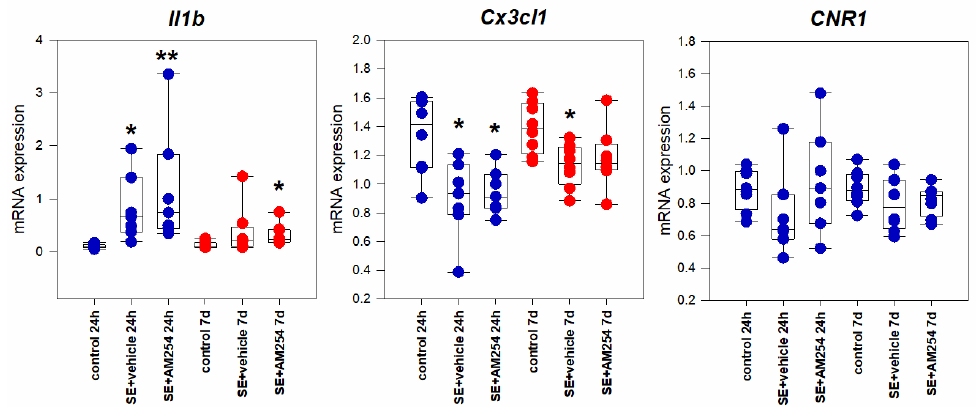
Figure 2. Il1b , Cx3cl1 , and CNR1 expression in the entorhinal cortex 24 h and 7 days after SE in rats